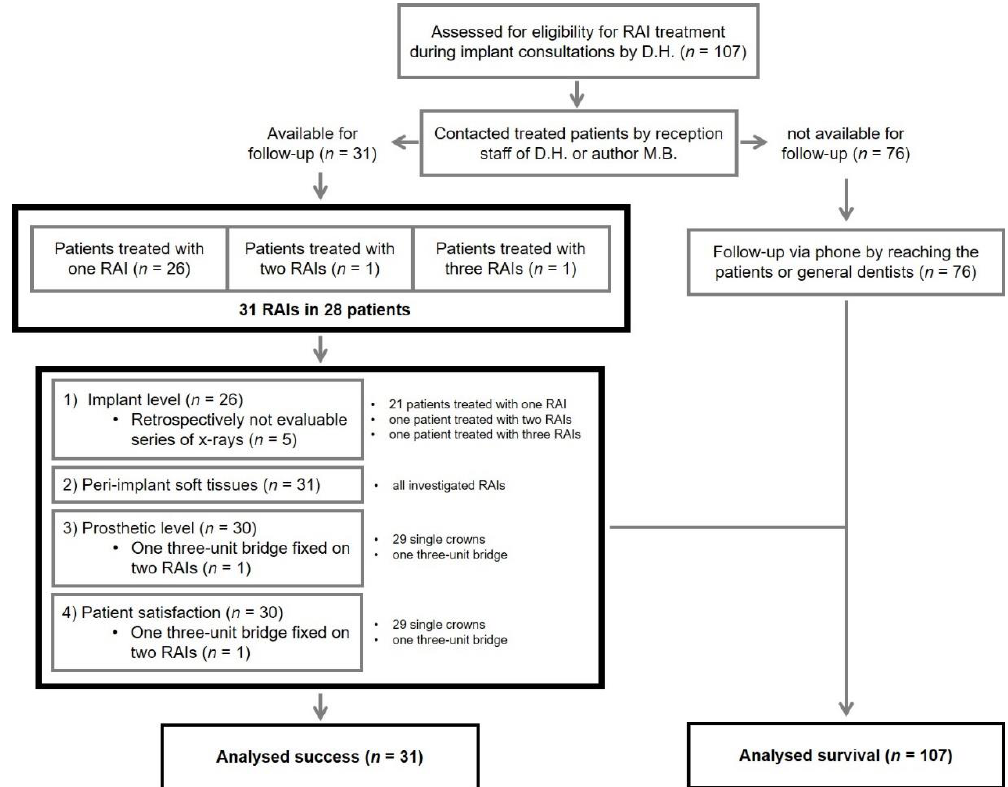
Figure 1. Flow diagram regarding study design and distribution; n : number of root- Figure1. Flowdiagramregardingstudydesignanddistribution; n : numberofroot-analogues / evaluated analogues/evaluated data within the different stages of the present study. data within the di ff erent stages of the present